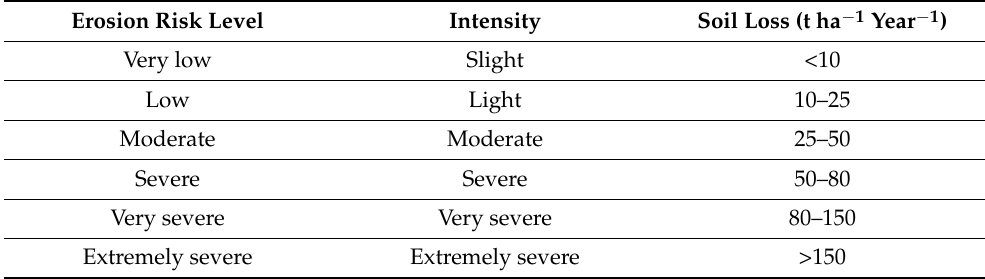
Table 3. Soil erosion risk level and